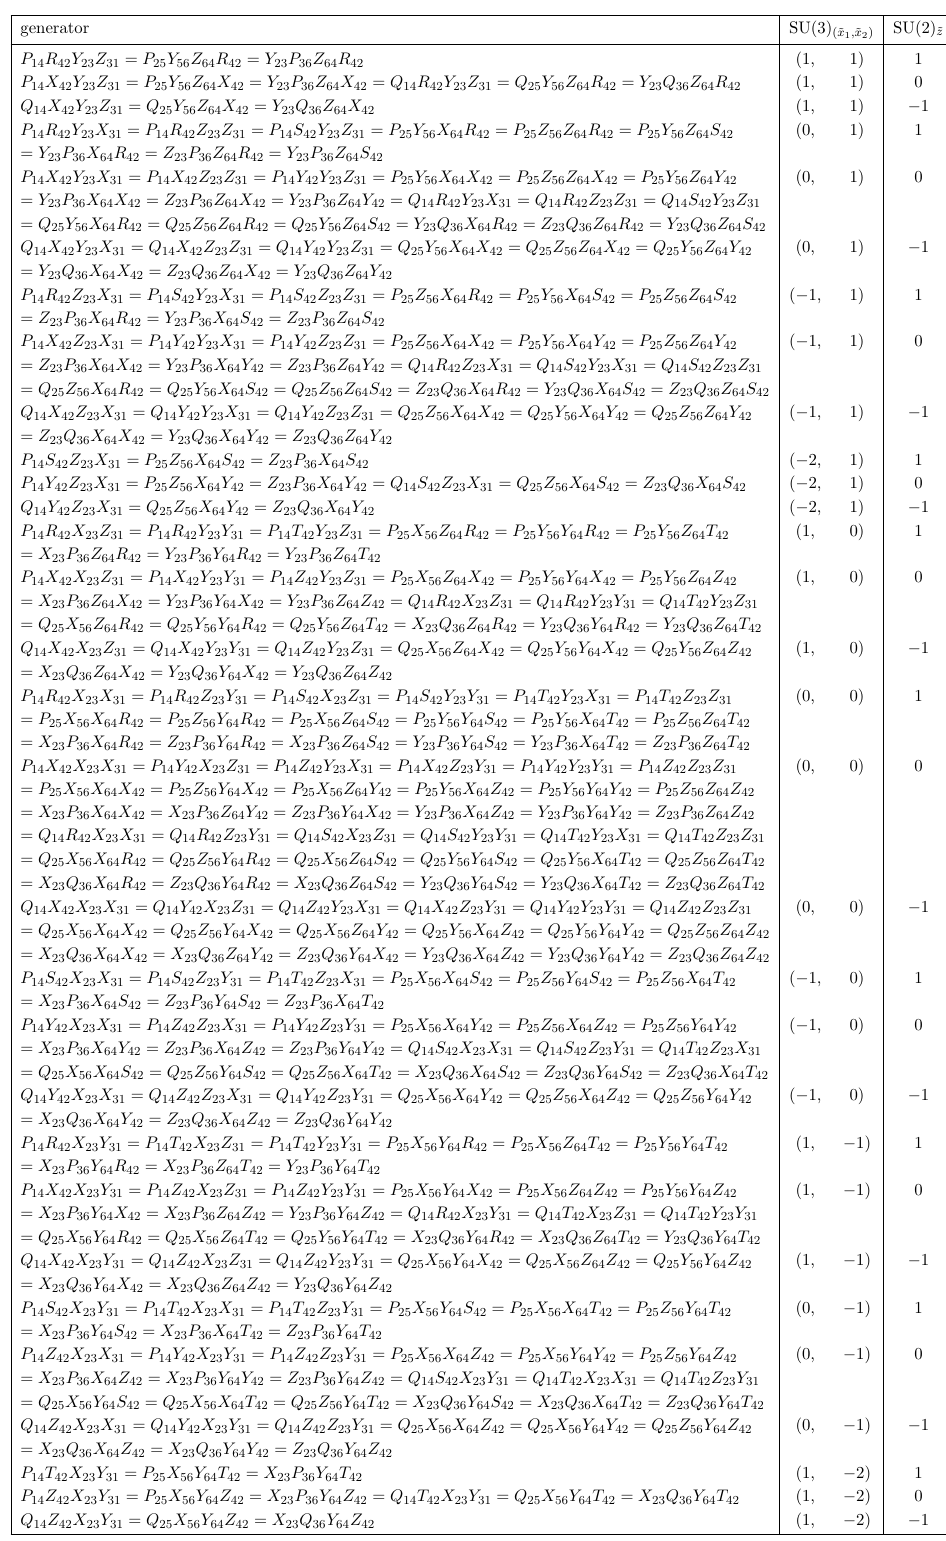
Table 11 . The generators in terms of bifundamental chiral fields for Model